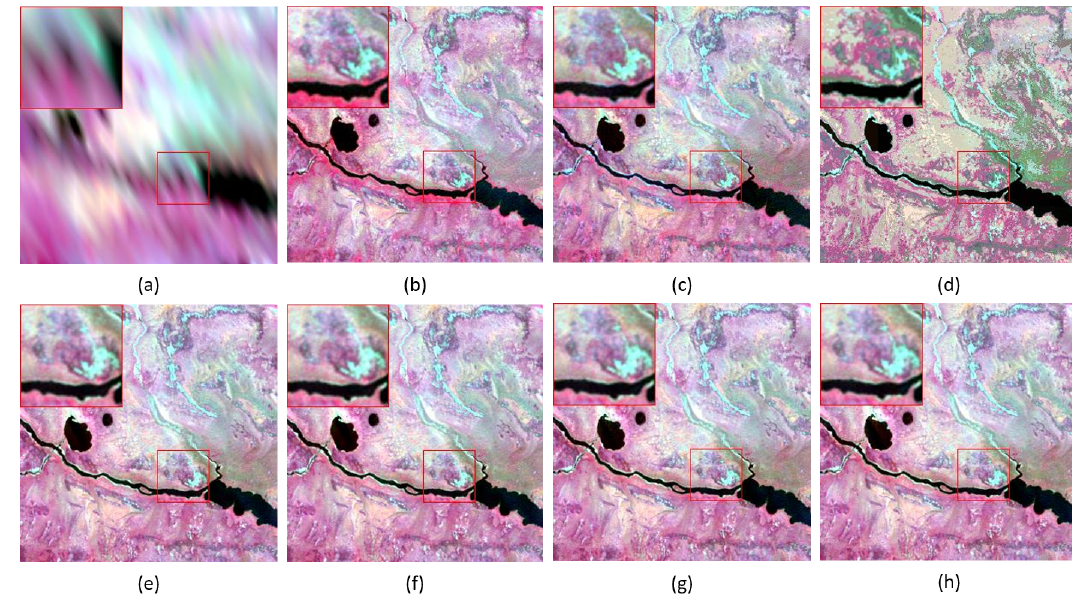
Figure 2. Comparisons between the true image 1 and images reconstructed by different fusion methods. ( a ) MODIS (Moderate Resolution Imaging Spectroradiometer); ( b ) true Landsat image; ( c ) ESTARFM (Enhanced Spatial and Temporal Adaptive Reflectance Fusion Model); ( d ) CRSU (Class Regularized Spatial Unmixing); ( e ) SPSTFM (Sparse-representation-based Spatiotemporal Reflectance Fusion Model); ( f ) EBSCDL (Error-Bound-regularized Semi-Coupled Dictionary Learning); ( g ) AMCFM (adaptive multi-band constraints fusion model); ( h ) AMCFM-s.